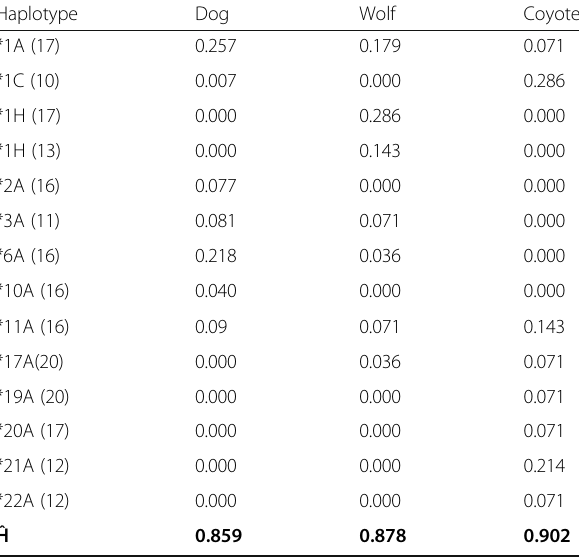
Table 3 Comparison of GSTP1 promoter haplotype in dogs, wolves and coyotes Haplotype